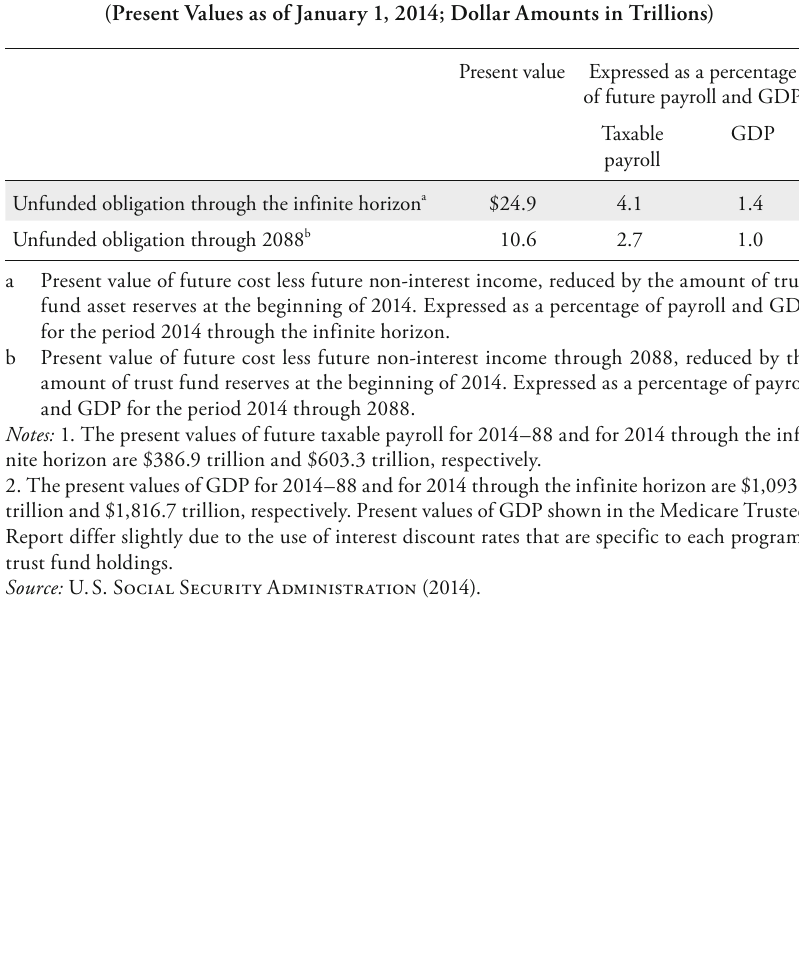
Table VI.F1: Unfunded OASDI Obligations Through the Infinite Horizon, Based on Intermediate